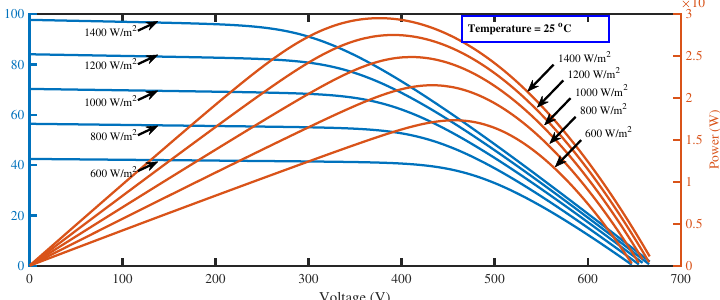
Figure 3. IV and PV characteristics curves of the PV array under fixed temperature and varying irradiance.